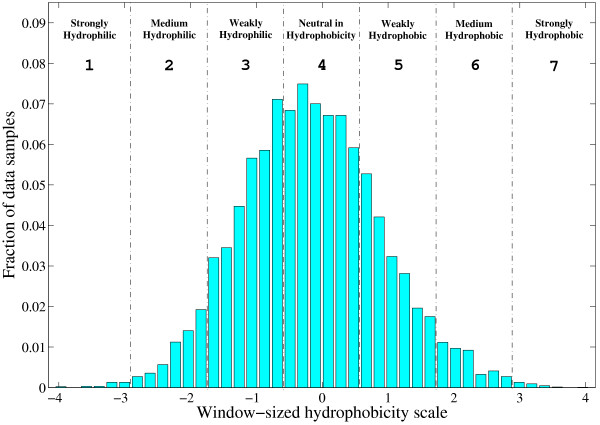
An illustration of ordered categorical values for the window-sized hydrophobicity.